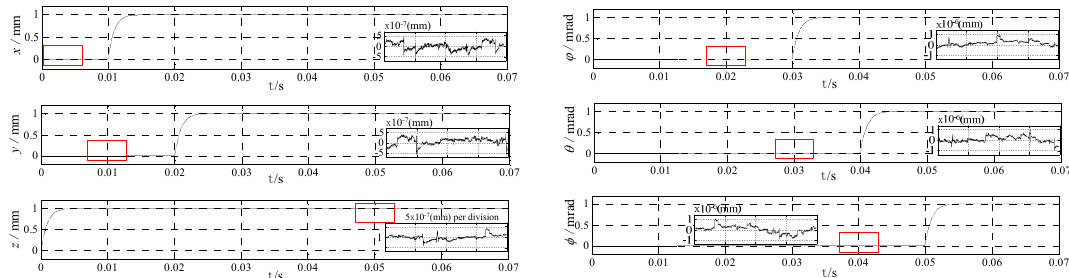
Figure 6. The displacement/angle curve with step response.